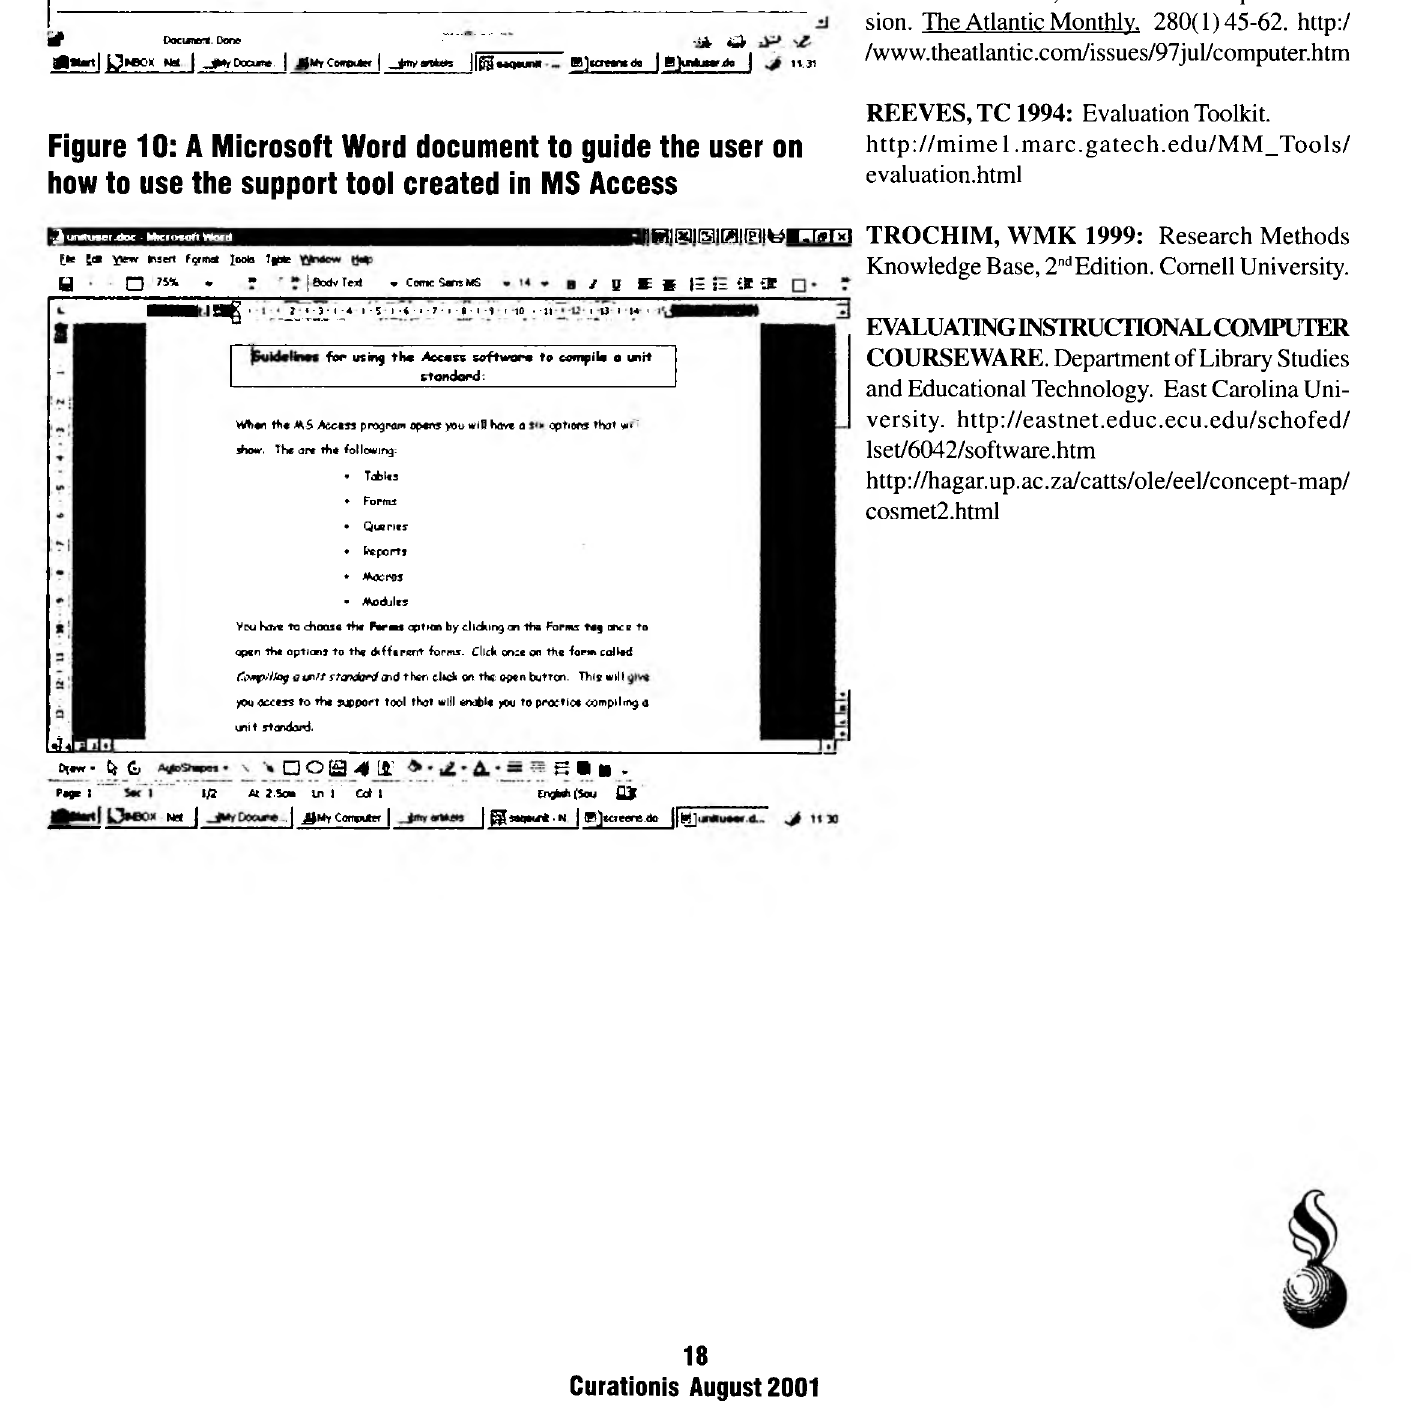
Figure 10 : A Microsoft Word document to guide the user on how to use the support tool created in MS